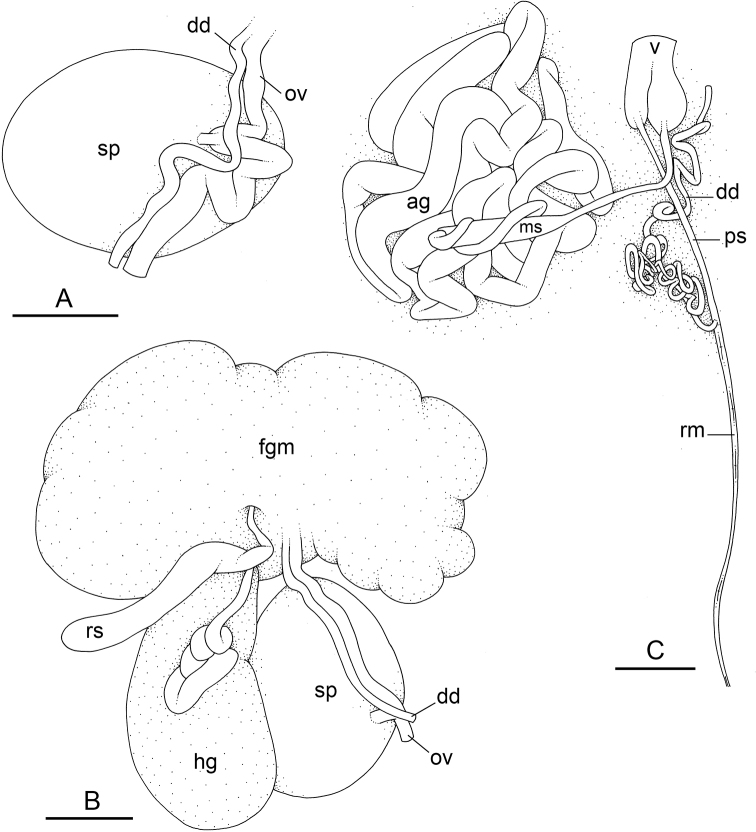
Reproductive system, Peronia
verruculata (unit #5), Madagascar A posterior, hermaphroditic (female) reproductive system, only the spermatheca, the deferent duct, and the oviduct, [3143] (MNHN-IM-2019-1611) B posterior, hermaphroditic (female) reproductive system, [3231] (MNHN-IM-2019-1610) C anterior, male, copulatory apparatus, same as B. Scale bars: 5 mm (A), 3 mm (B), 4 mm (C). Abbreviations: ag accessory penial gland, dd deferent duct, fgm female gland mass, hg hermaphroditic gland, ms muscular sac, ov oviduct, ps penial sheath, rm retractor muscle, rs receptaculum seminis, sp spermatheca, v vestibule.